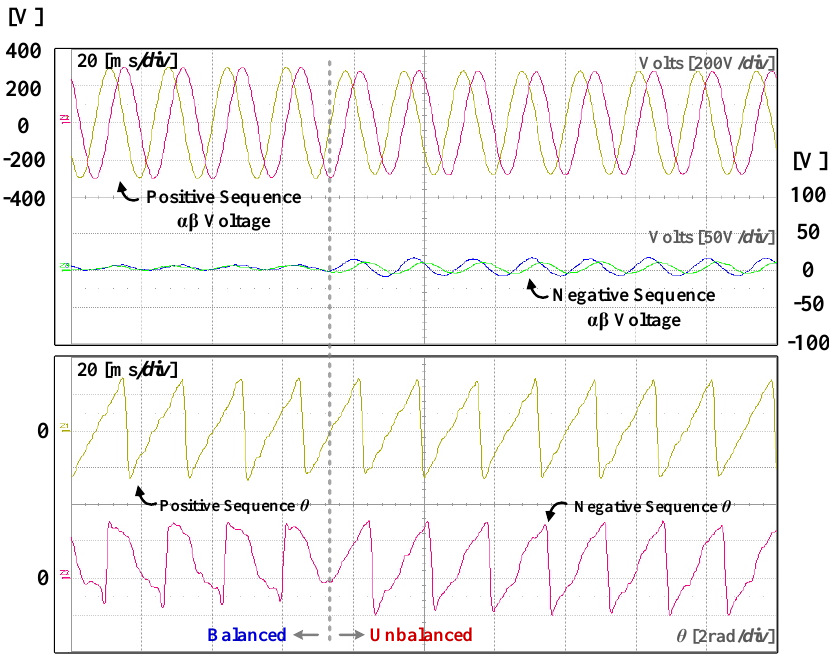
Figure 29. Waveform of detected positive/negative sequence αβ voltage and phase angle θ (before and after b phase voltage drop).